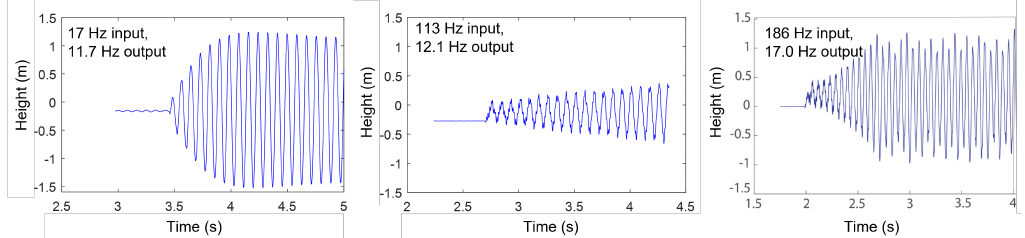
Figure 9. Displacement of the tip of the amplification mechanism when driven near prominent peaks in frequency response (from left: 17 Hz, 113 Hz, 186